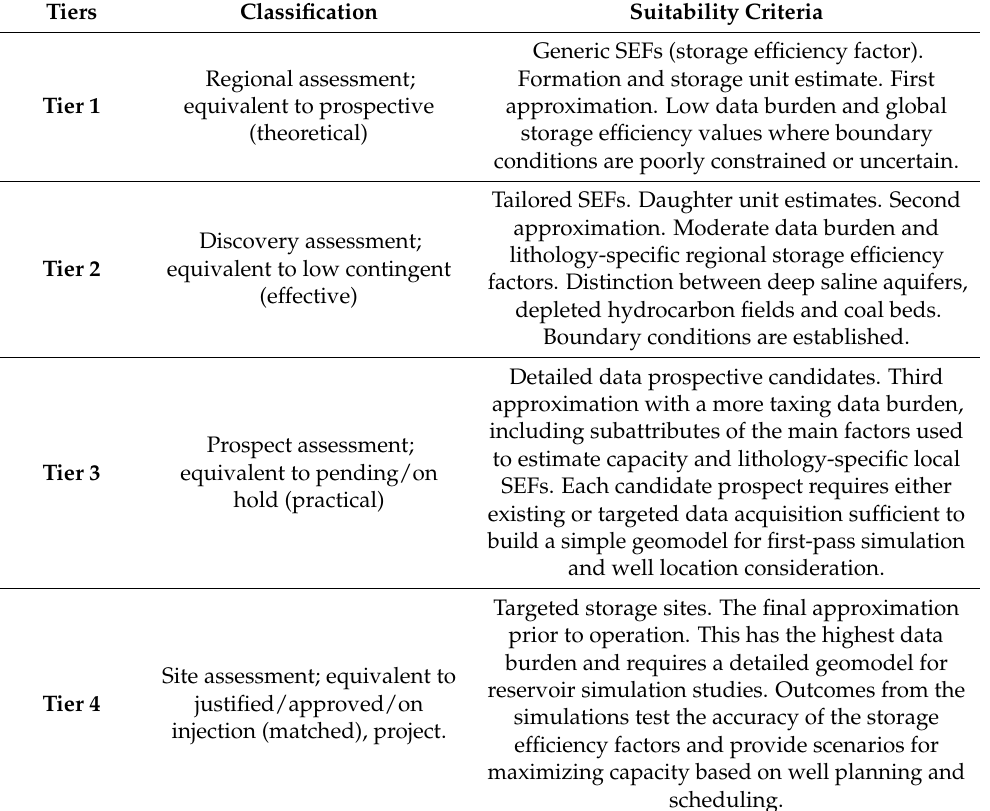
Table 1. Tier classification/definition and suitability criteria defining the maturity of geological CO 2 storage resource